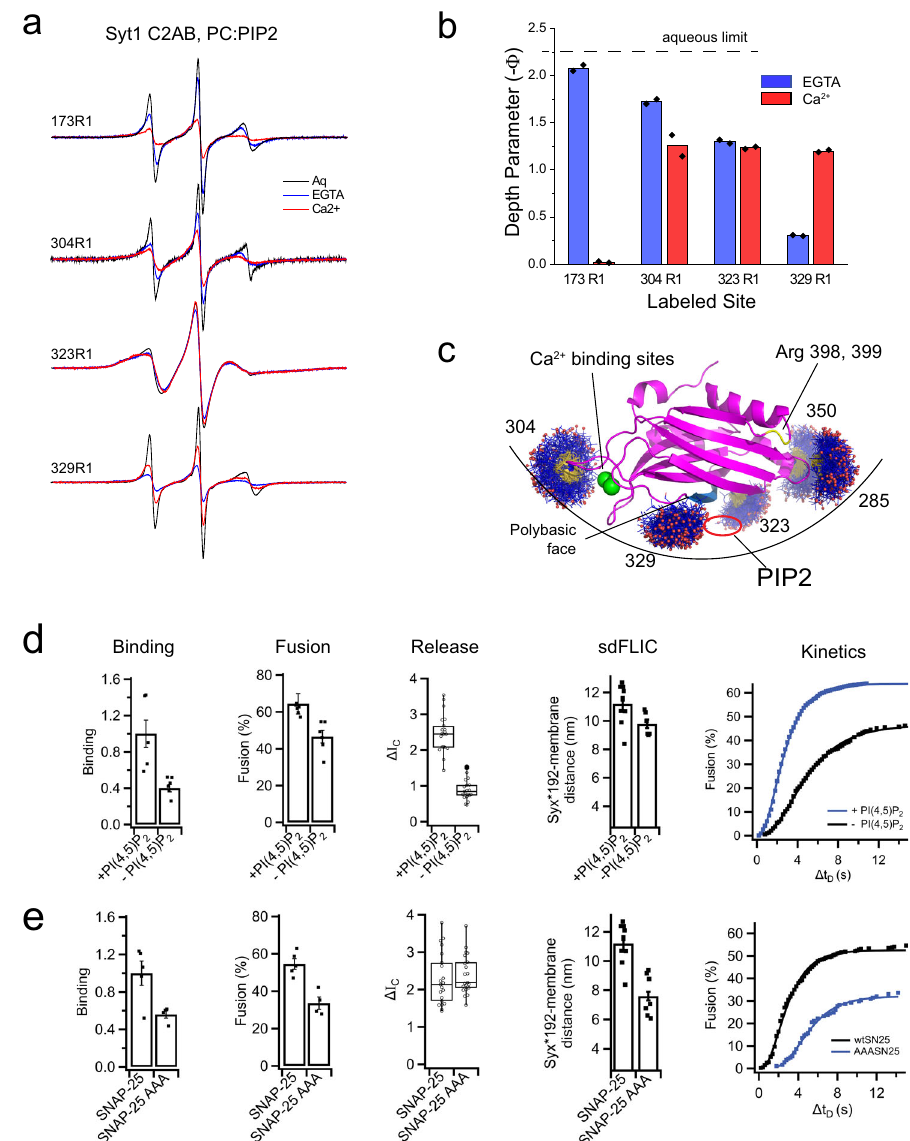
Fig. 6 The C2B domains makes simultaneous membrane contact at multiple sites that cannot be explained by docking to a planar bilayer surface. a EPR spectra in an aqueous state compared with spectra in the presence of POPC:PIP 2 (95:5) bilayers in the presence of EGTA or Ca 2 + . b Membrane depth parameters indicate that site 173 inserts into the PIP 2 bilayer in the presence of Ca 2 + . Sites on C2B including 304, 323, and 329 also contact with bilayer, with or without Ca 2 + . Bar plots show mean values from the power saturation of two samples. c Allowable rotamers for labeled sites that contact the membrane interface including two near the arginine apex. The membrane contact seen at these sites could be accommodated by a curved membrane surface. This would place a PIP 2 headgroup in a binding pocket at the polybasic face. d The effect of PIP 2 on granule binding, fusion, release pro fi le, SNARE orientation, and fusion kinetics in the presence of 100 µ M Ca 2 + (membrane composition was 25:25:15:30 bPC:bPE:bPS:Chol and either 5% PI or 4% PI with 1% PIP 2 ). e The effect of the AAA mutation in SNAP-25 on granule binding, fusion, release pro fi le, SNARE orientation, and fusion kinetics in the presence of 100 µ M Ca 2 + (membrane composition 32:32:15:20:1 bPC:bPE:bPS:Chol:PIP 2 ). The bar plots show mean ± standard error of the mean. The boxplots show mean, 2nd and 3rd quartile, and outliers of the